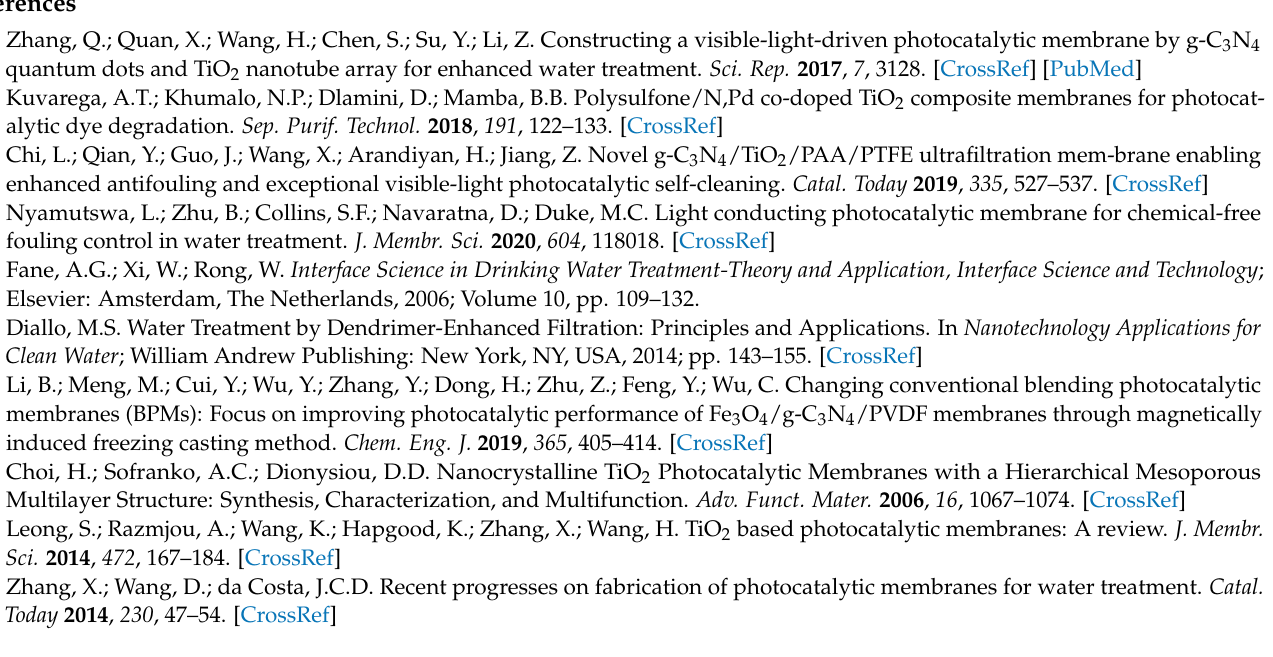
various materials. Figure S4: UV/Vis spectra of (a) unmodified TiO 2 and 1% CuO/TiO 2 @GCN (1:9) nano-composite and (b) their extrapolated energy bandgaps based on Kubelka-Munk method. S9: Method description of the analyses of membrane properties. S10: Method description of how the efficiency of the photocatalytic membrane was evaluated. S11: Description on how the electrical con- sumption was calculated. Table S1: The water quality characteristics of the different water matrixes used in this work. Figure S5: Series of steps for recycling the membranes and (d) ATR-FTR spectra of fresh CTG-500 membrane and after several cycles. Figure S6: Chromatograms of (a) uncatalyzed and (b) photodegraded KP after 5 h; (c) mass spectrum for a peak at retention time 3.09 min. Figure S7: Proposed photodegradation pathway and the intermediates of